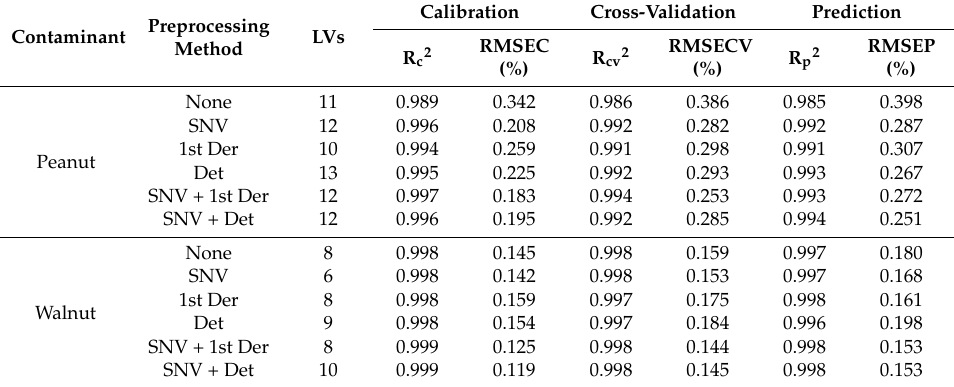
Table 1. Partial least squares regression (PLSR) models for the detection of peanut-contaminated flour and walnut-contaminated flour based on full spectra. SNV: standard normal variate; 1st Der: Savitzky–Golay first derivative; Det: de-trending.